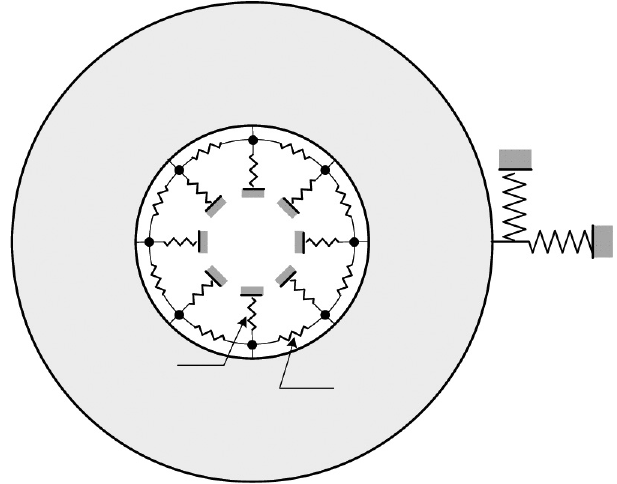
Fig. 2. Annular disk clamped at the inner edge and with elastic point support at the outer